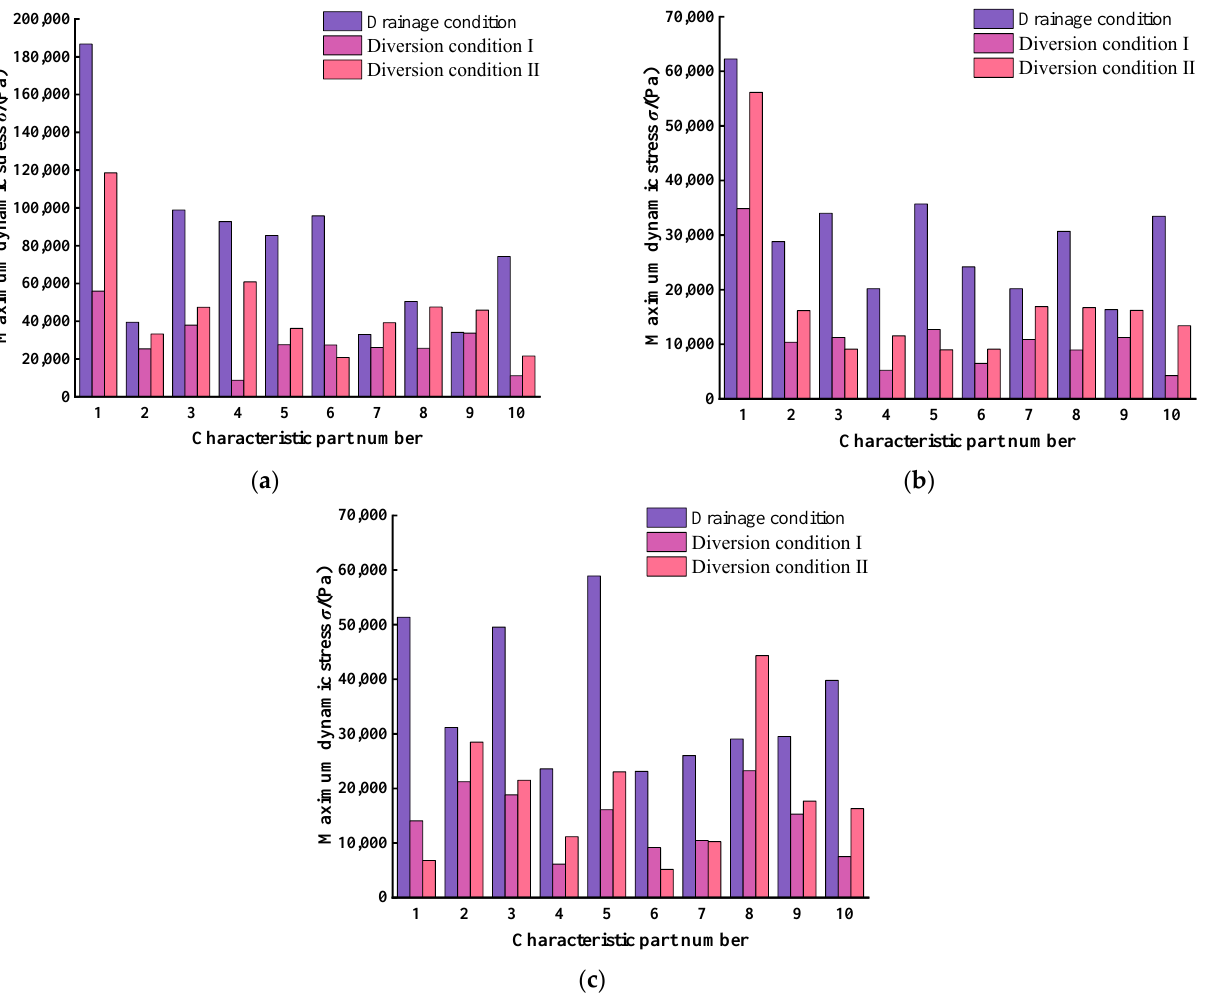
Figure 15. Maximum dynamic stress at characteristic parts: ( a ) X -axis; ( b ) Y -axis; ( c ) Z -axis.